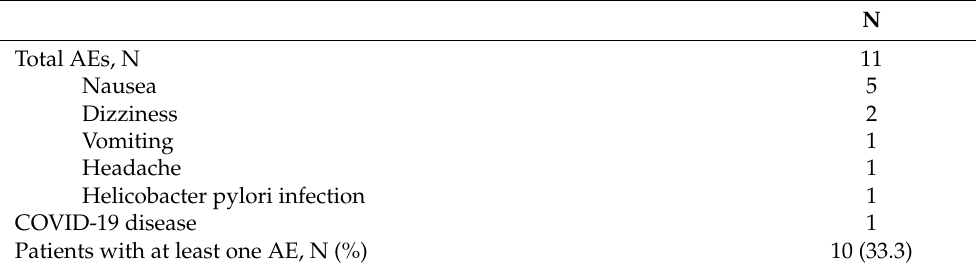
Figure 3. Clinical global impression of changes according to the patient’s (PGI-C) and clinician’s (CGI-C) opinion (N = 27). Total number of patients accorded to each category are shown ( y -axis). A total of 11 adverse events in 10 patients (33.3%) were reported—one of which was severe (vomiting related to vortioxetine, with full recovery 6 days later after drug withdrawal; Table 4). Gastrointestinal symptoms (nausea, N = 5; vomiting, N = 1; 20%) and dizziness (6.6%) were the most frequent. A full recovery was observed in 9 out of 11 (81.8%) adverse events. Three patients discontinued due to different reasons: personal decision of the patient (N = 1); changes in treatment by a psychiatrist; or an SAE (severe adverse event; N = 1). Table 4. Adverse events in patients from VB to V12w.